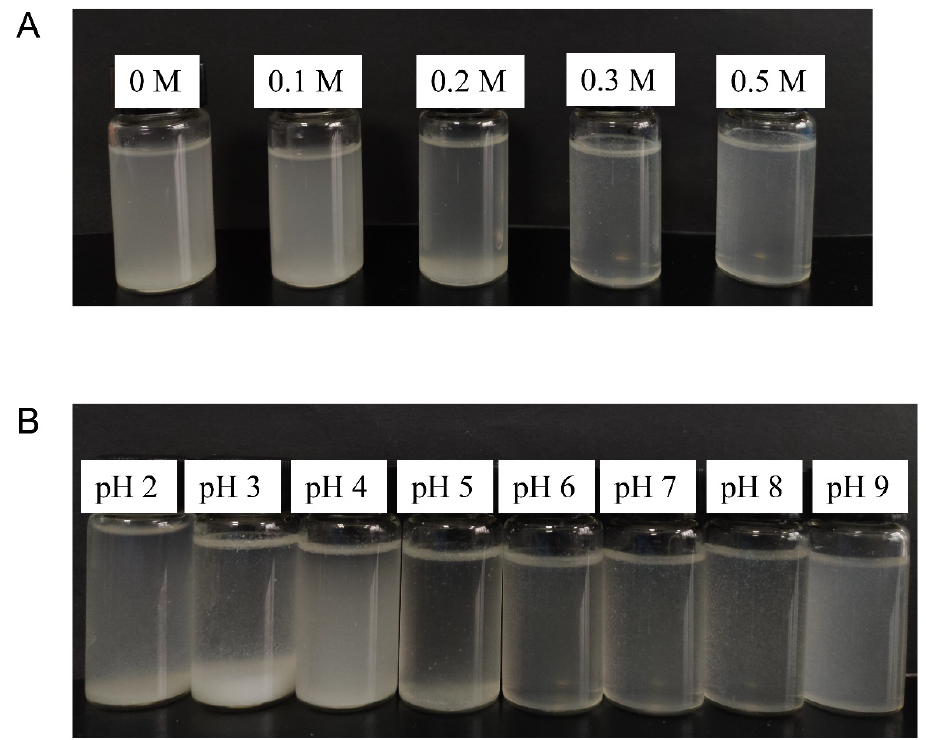
Figure 2. Visual appearance of suspension of EYGs at different NaCl ionic strength ( A ) and at a NaCl ionic strength of 0.3 M with different pH ( B ).